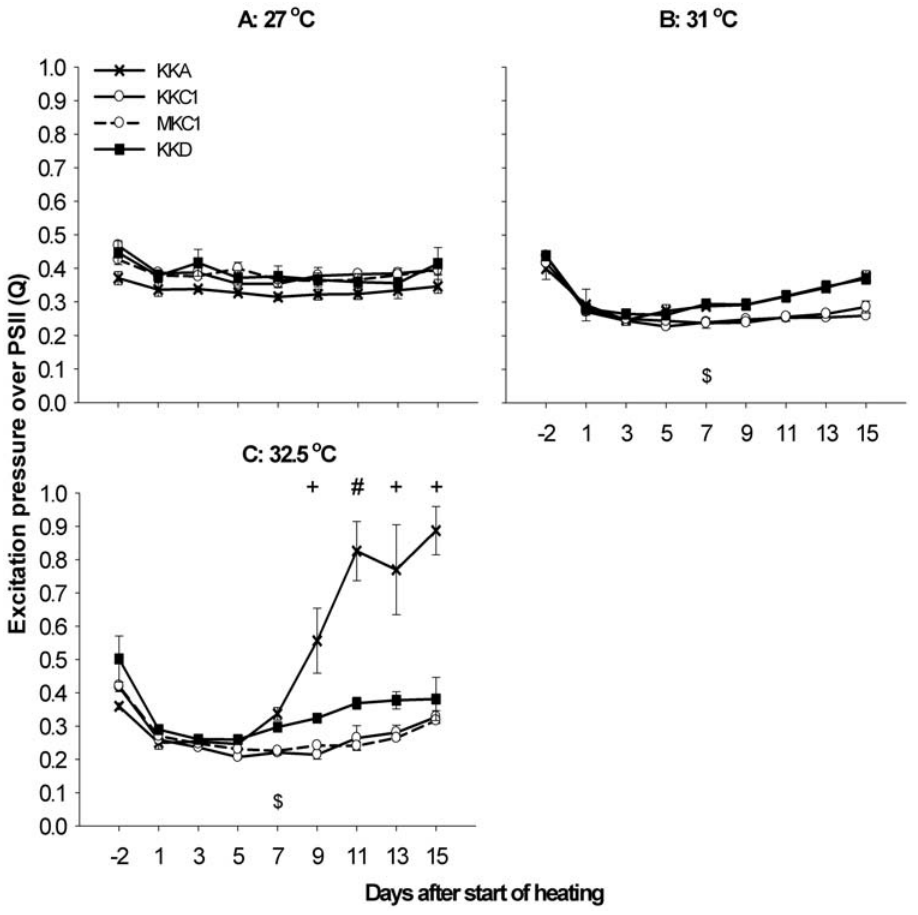
Figure 4. Heat-stress experiment 2: PAM-fluorometry. Effect of three different temperature regimes on the excitation pressure over photosystem II of three groups of juvenile coral outplanted to the Keppel Islands, and one outplanted to Magnetic Island. See materials and methods for nomenclature. $=target temperature is reached, + =significant difference between KKA and MKC1/KKC1/KKD corals (p , 0.001), # =significant difference between all three symbiont types (p , 0.05). KKA corals responded much stronger to the heat-stress than the other three juvenile coral groups, as indicated by a sharp increase in Q values for KKA corals in the highest temperature treatment relatively early in the experiment.